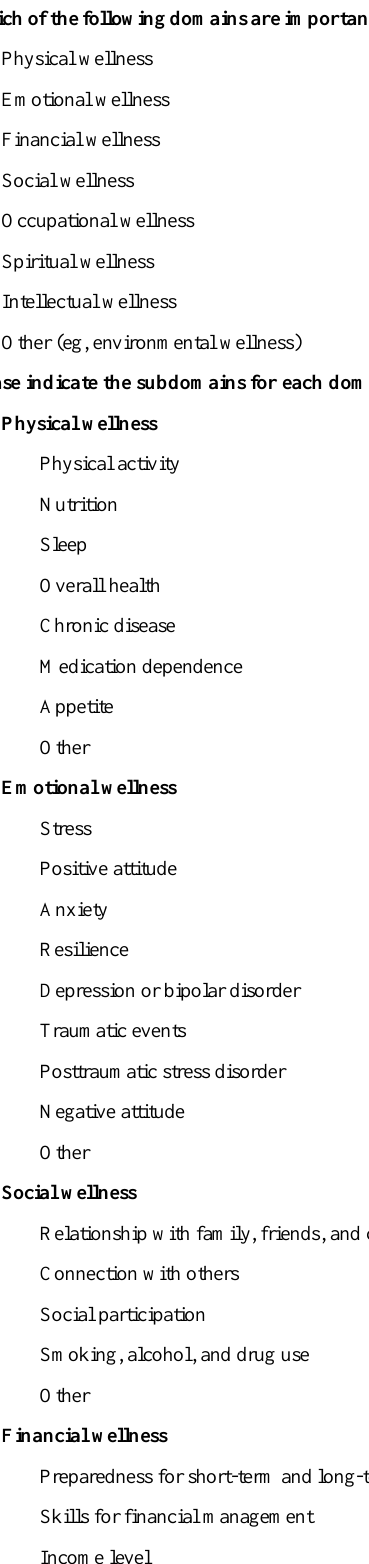
Value, n (%)Question